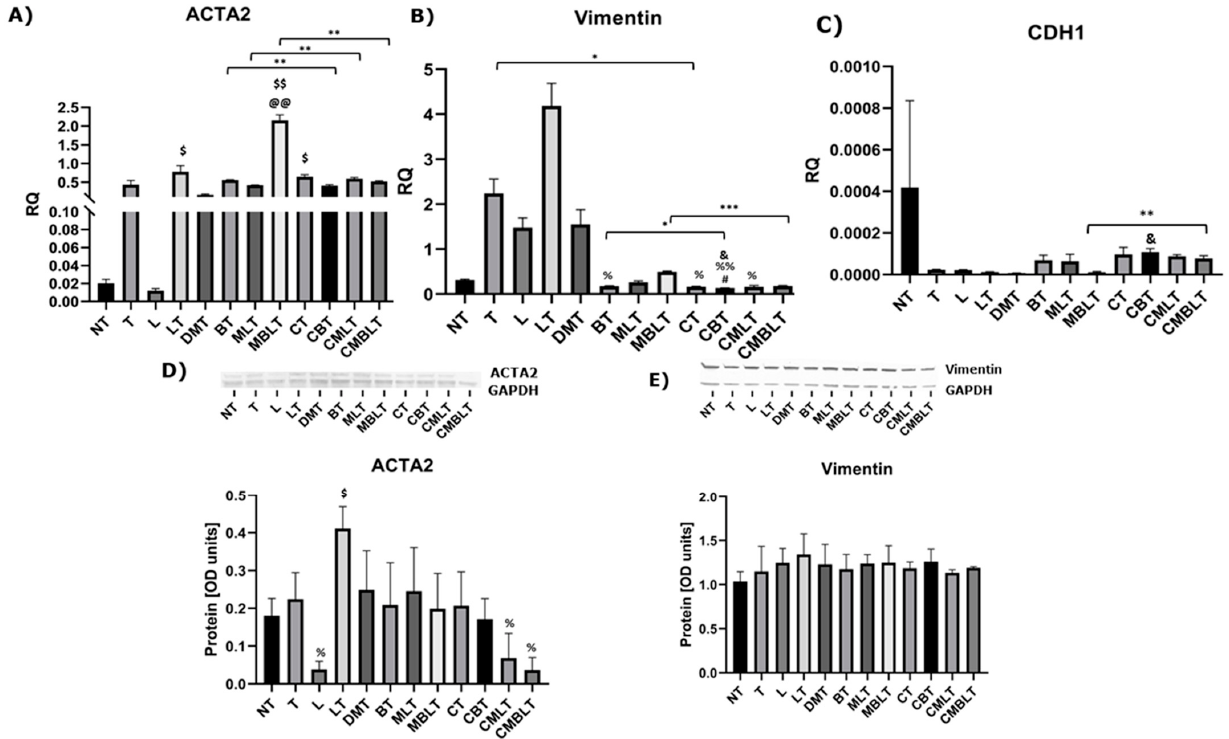
Figure 2. Calcitriol, beclomethasone 17-propionate and montelukast sodium effect on the expression of ACTA2, CDH1 and Vimentin. ( A – C ) mRNA expression and ( D , E ) protein level of ACTA2, CDH-1 and Vimentin after exposure to calcitriol, beclomethasone 17-propionate, montelukast sodium, LTD4 and TGF- β . The results of experiments (n = 3) are presented in relation to GAPDH as mean ± SEM. Western blots are shown for genes, in which the statistical significance has been observed at the mRNA level. Original Western blots can be found in Figure S1. @@ p < 0.01 versus NT group; # p < 0.05 versus T group; $ p < 0.05, $$ p < 0.01 versus L group; % p < 0.05, %% p < 0.01 versus LT group; and & p < 0.05 versus DMT group; * p < 0.05, ** p < 0.01, *** p < 0.001. One-way analysis of variance (ANOVA) or Kruskal-Wallis